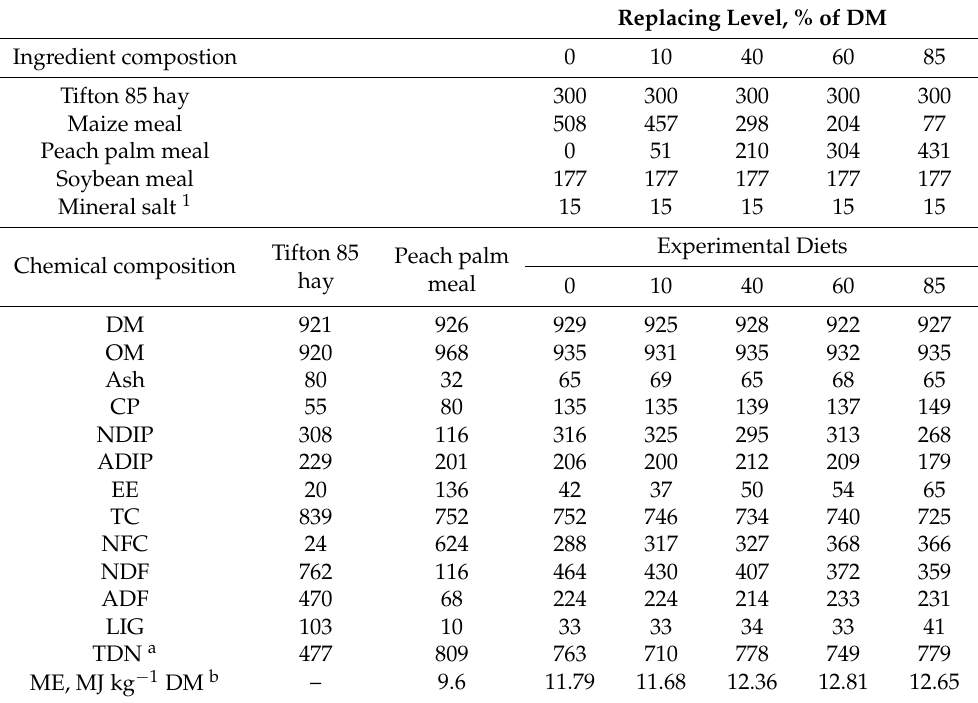
Table 1. Ingredient composition (g kg − 1 DM) of the diets; chemical composition of the Tifton 85 hay; peach palm meal and experimental diets.